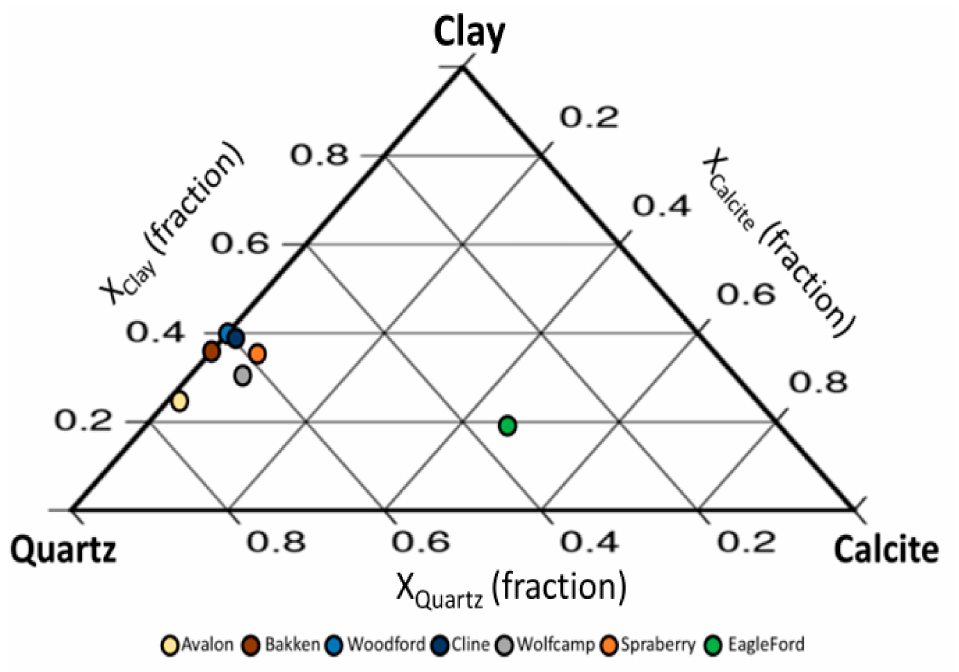
Figure 1. Ternary volume fraction composition diagram for average formation properties in our dataset for shale reservoirs in the quartz–clay–calcite system with the volume fractions normalized to sum to unity. Other constituents are neglected on this diagram. The Eagle Ford is compositionally a dirty limestone. The Avalon is abnormally quartz rich. The Woodford has zero calculated calcite. The Bakken has no computed calcite but has significant dolomite content and high